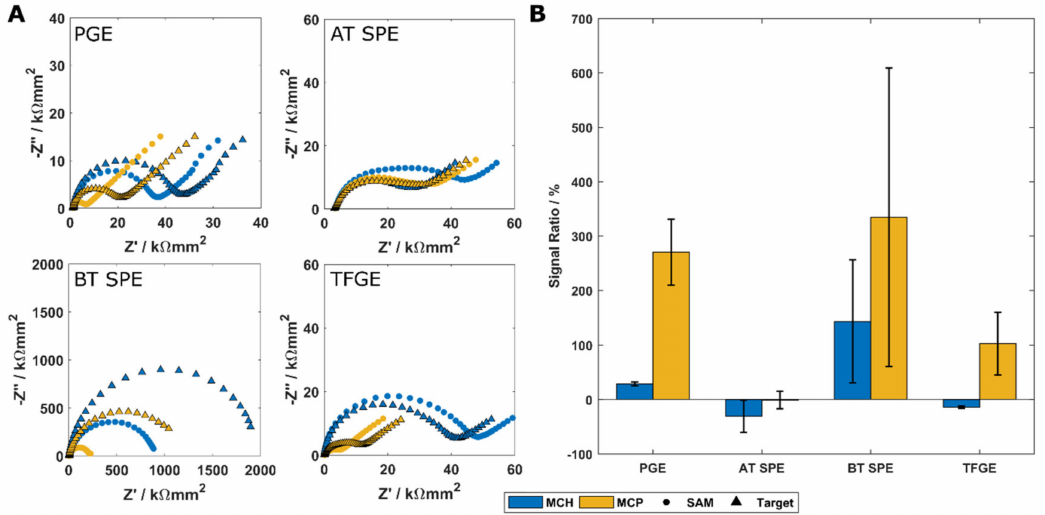
Figure 4. Impedance responses of polycrystalline gold electrodes, AT and BT SPEs, and thin-film gold electrodes. ( A ) Example area-corrected impedance responses of each electrode type with different SAM layers. ( B ) Mean percentage change in charge transfer resistance in response to DNA target binding on each electrode type. Error bars indicate standard deviation, n =